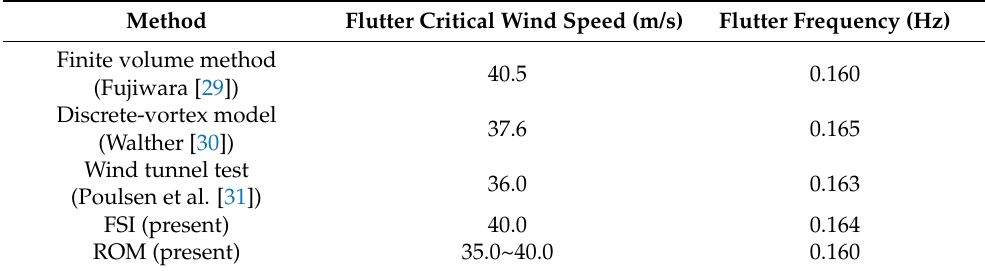
Table 4. Comparisons of flutter results of the girder of GBEB.